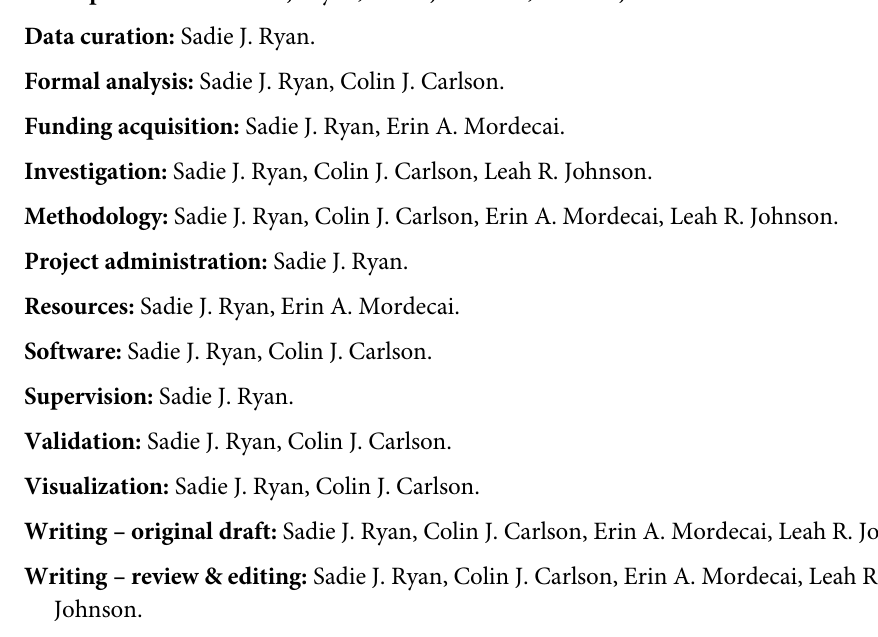
S1 Table. Changing year-round (12 month) population at risk due to temperature suitabil- ity for Aedes aegypti virus transmission. All values are given in millions; future projections are averaged across GCMs, broken down by year (2050, 2080) and RCP (2.6, 4.5, 6.0, 8.5), and are given as net change from current population at risk. 0+/0- denote the sign of smaller non- zero values that rounded to 0.0, whereas “0” denotes true zeros. (Losses do not indicate loss of any transmission, only to reduction 11 or fewer months.). S2 Table. Changing year-round (12 month) population at risk due to temperature suitabil- ity for Aedes albopictus virus transmission. All values are given in millions; future projections are averaged across GCMs, broken down by year (2050, 2080) and RCP (2.6, 4.5, 6.0, 8.5), and are given as net change from current population at risk. 0+/0- denote the sign of smaller non- zero values that rounded to 0.0, whereas “0” denotes true zeros. (Losses do not indicate loss of any transmission, only to reduction 11 or fewer months). S3 Table. Top 10 regional increases in populations experiencing year-round temperature suitability for transmission (12 months). Regions are ranked based on millions of people exposed for the first time to any transmission risk; parentheticals give the net change (first exposures minus populations escaping transmission risk). All values are given for the worst- case scenario (RCP 8.5) in the longest term